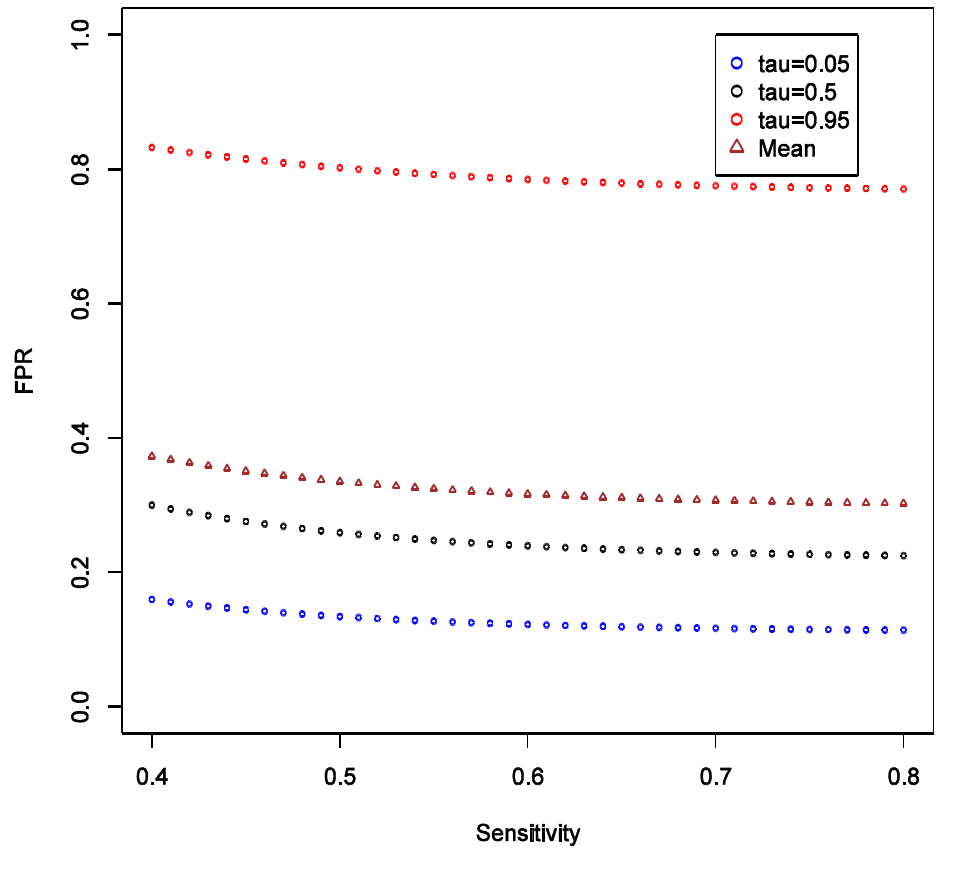
Figure 3. Theoretical calculations of the impact of varying sensitivity of exposure classifier while keeping specificity fixed at 0.9; tau (τ) = expected quintiles of the distribution for false positive rate (FPR); see text for details of other parameter